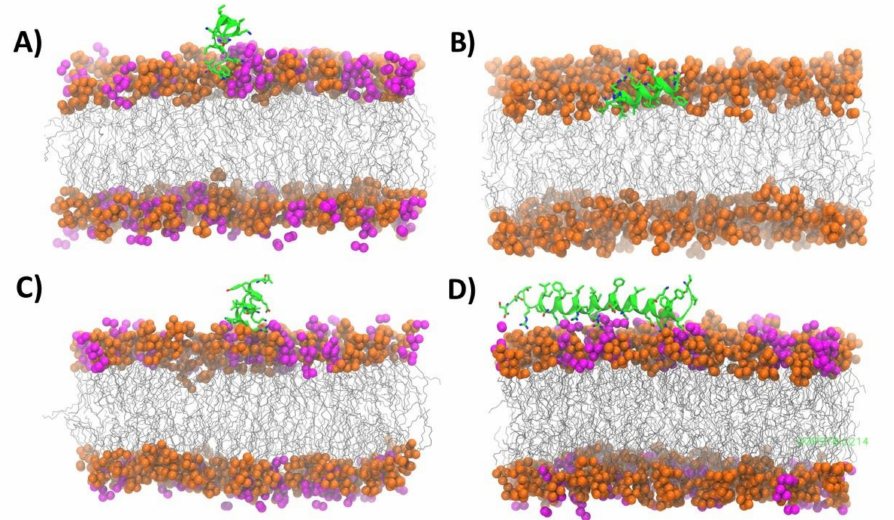
Figure 6. Membrane orientation of selected ACPs in the MD simulations. ( A ) Lasio III in the presence of PC/PS bilayer. ( B , C ) Tempo-La in the presence of PC and PC/PS bilayer, respectively. ( D ) LL-37 in the presence of PC/PS bilayer. The backbone of the peptides is shown as green cartoon. The lipid head groups are represented by orange (PC) and magenta (PS) spheres, while the lipid alkyl chains are grey lines. The H-atoms are not shown for better clarity. Representative snapshots were taken at the end of the simulations (at 500